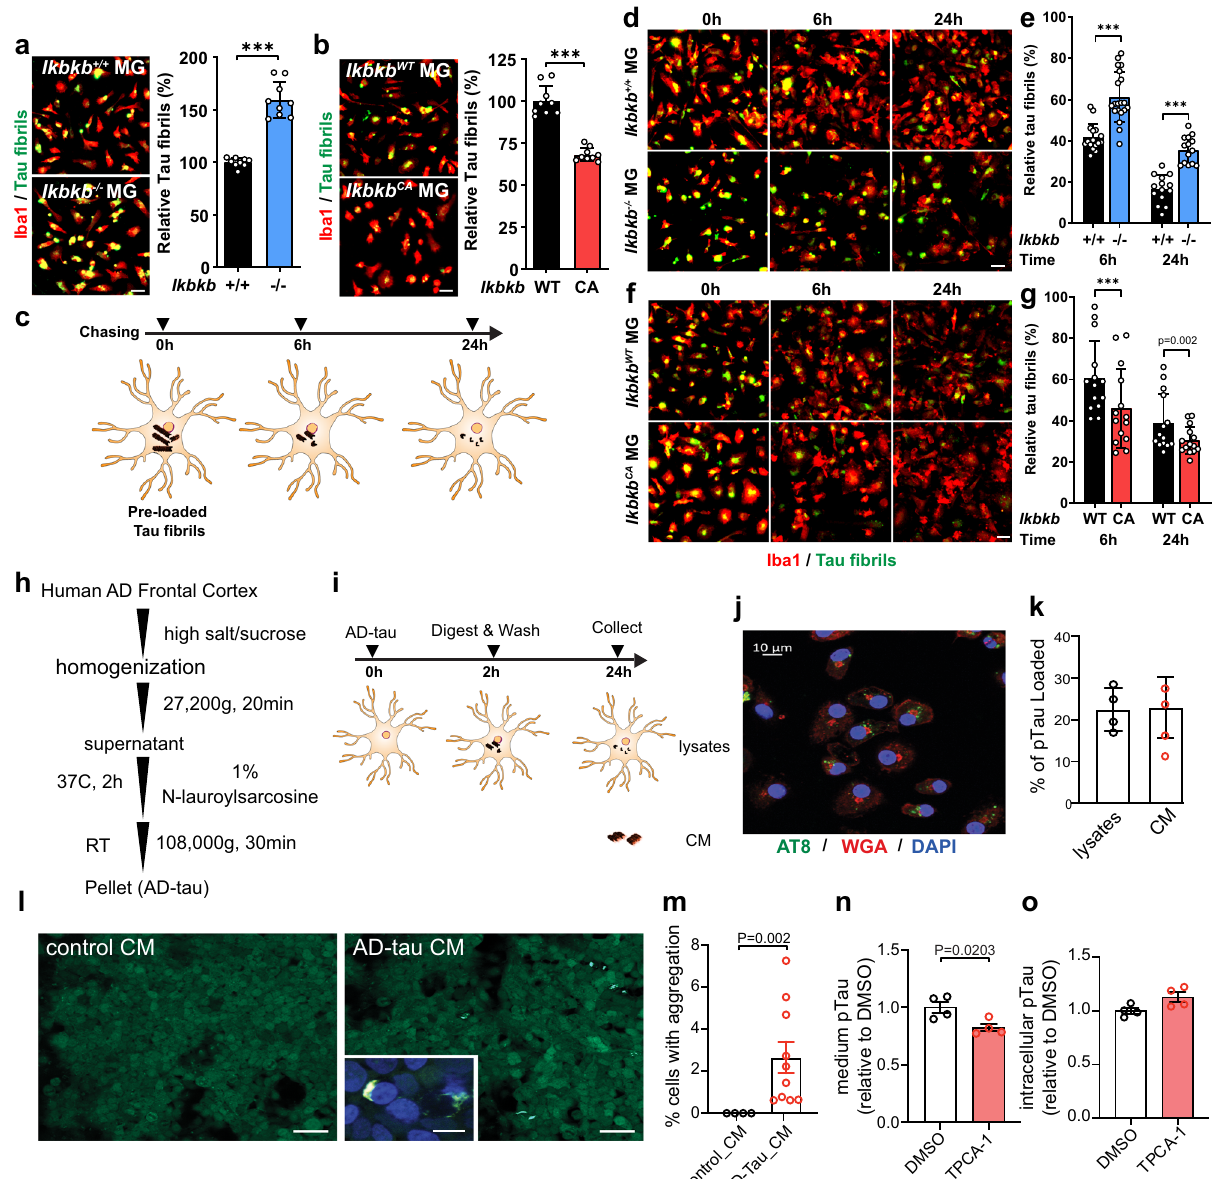
Fig. 3 NF- κ B promotes tau processing in primary microglia. a, b Representative images and quanti fi cation of 24 h fl uorescent tau fi brils accumulation in primary Ikbkb − / − ( a ) and Ikbkb CA ( b ) microglia compared with their littermate Ikbkb + / + and Ikbkb WT control, respectively. Scale bar, 25 μ m. Values are mean ± SD, relative to littermate control. Total N = 9 wells/group from three independent experiments. P -values were from multilevel mixed-effect model with experiment as hierarchical level, *** p < 0.001. c Schematic diagram of pulse-chase assay to quantify tau clearance in microglia. d – g Representative images and quanti fi cations of pulse-chase assay comparing Ikbkb − / − with Ikbkb + / + microglia ( d , e 25,000 cells/well) and comparing Ikbkb CA with Ikbkb WT microglia ( f , g 20,000 cells/well). Scale bar, 25 μ m. Values are mean ± SD, relative to 0 h. Total N = 16 wells (6 h, Ikbkb + / + ); 20 wells(6 h, Ikbkb − / − ); 14 wells/group of other conditions from three independent experiments. P -values were from multilevel mixed-effect model with experiment as hierarchical level, *** p < 0.001. h Schematic diagram illustrating the isolation procedures of human AD-tau. i Schematic diagram of quantifying release of AD-tau from microglia. j Detection of intracellular pTau by AT8 (green), cell membranes by Wheat Germ Agglutinin (WGA) (red), and nuclei by DAPI (blue). A representative image from three independent experiments. Scale bar: 10 μ m. k Quanti fi cation of secreted and the intracellular pTau by AT8 ELISA and shown as the percentage of total pTau loaded in microglia after 2 h incubation. N = 4 wells. A representative dataset from two independent experiments. Values are mean ± SEM. l Representative images of tau aggregation in HEK biosensor cells induced by CM from microglia treated with AD-tau. Insert: High magni fi cation confocal image of tau aggregation. Scale bar: 50 μ m, insert: 15 μ m. m Quanti fi cation of tau aggregation positive cells. N = 4 (control) and 10 (AD-tau) fi elds from three independent experiments, values are mean ± SEM, two-tailed Mann – Whitney test. n , o TPCA-1-treated microglia were incubated 2 h with AD-tau followed by 24 h chase. The pTau released to medium ( n ) and intracellular pTau ( o ) were determined by AT8 ELISA. A representative dataset from two independent experiments. N = 4 wells, values are mean ± SEM, relative to DMSO, two-tailed t -test. Source data are provided as a Source data fi